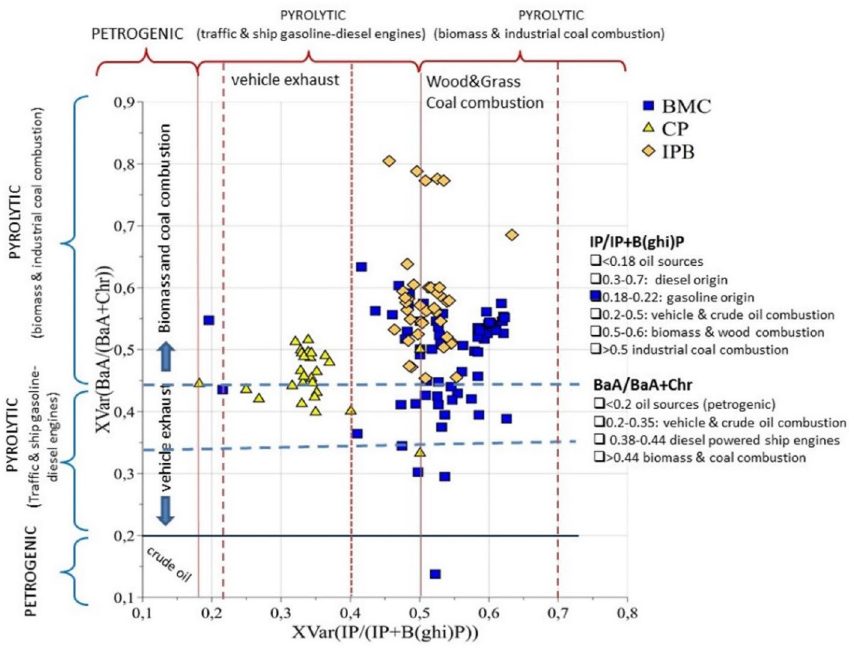
Figure 6. 2D-plot displaying BaA/(BaA + Chr) versus IP/(IP + BghiP) isomeric ratios: intervals of values useful to attribute the PAH sources are identified.